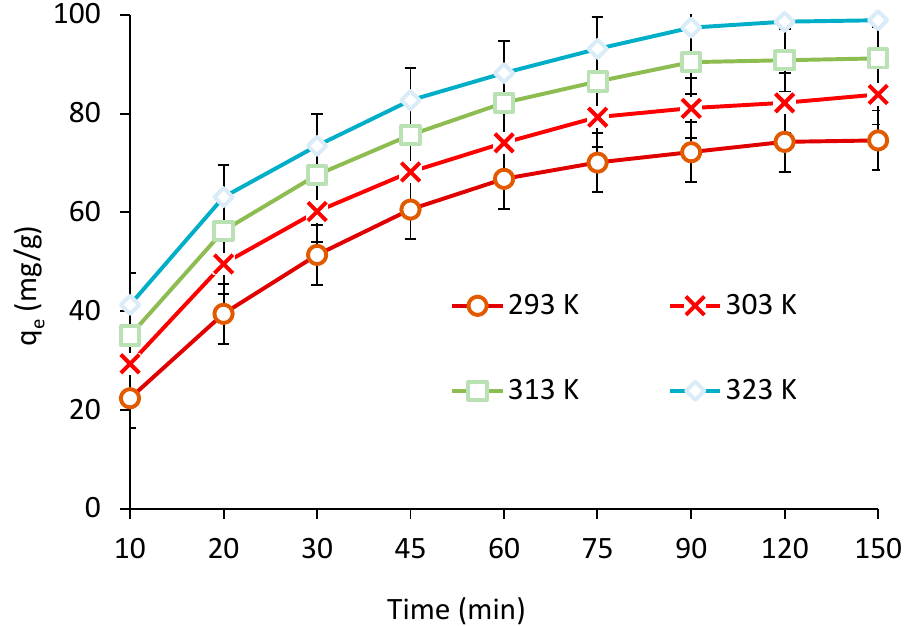
Figure 8. The effect of temperature on antibiotic uptake in the optimal number of other parameters. The values of ∆ H ◦ and ∆ S ◦ were determined from the intercept and slope values of the straight line of plotting of ln K versus 1/T. The obtained ∆ H ◦ was 68.65 kJ · mol − 1 , and this indicates that the process is endothermic [60,61]. The ∆ G ◦ values were − 2.32, − 3.65, − 5.82 and − 9.72, at 293, 303, 313, and 323 K, respectively. These results showed that with increasing the temperature, the Gibbs free energy value decreased. Moreover, the negative ∆ G ◦ values indicate that the adsorption process was spontaneous, which supports the feasibility of the adsorption process. Furthermore, this indicates the desirability of adsorption at high temperatures [62]. In addition, a high enthalpy value of 40 kJ · mol − 1 indicates the chemical adsorption of LFX on the MWCNTs/CoFe 2 O 4 , which confirms the results of isotherm studies [63]. In addition, positive entropy values (0.24 kJ · mol − 1 · K − 1 ) also indicate that increases in randomness, including the number of species at the solid– liquid interface during the adsorption process